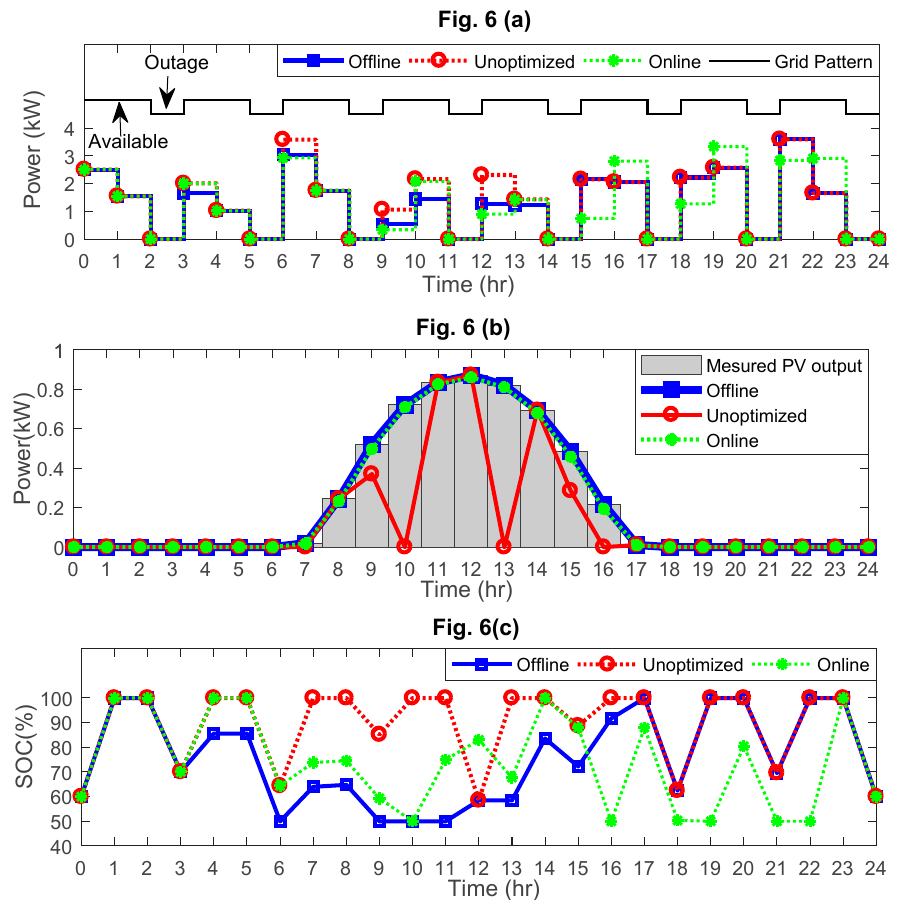
Figure 6. Comparison for Optimized and Base Case Scenario in a 24-h operation with 8 h of load shedding (grid unavailable). ( a ) Load power demand from the grid, ( b ) Solar Resource Utilization, ( c ) Battery SOC variations.